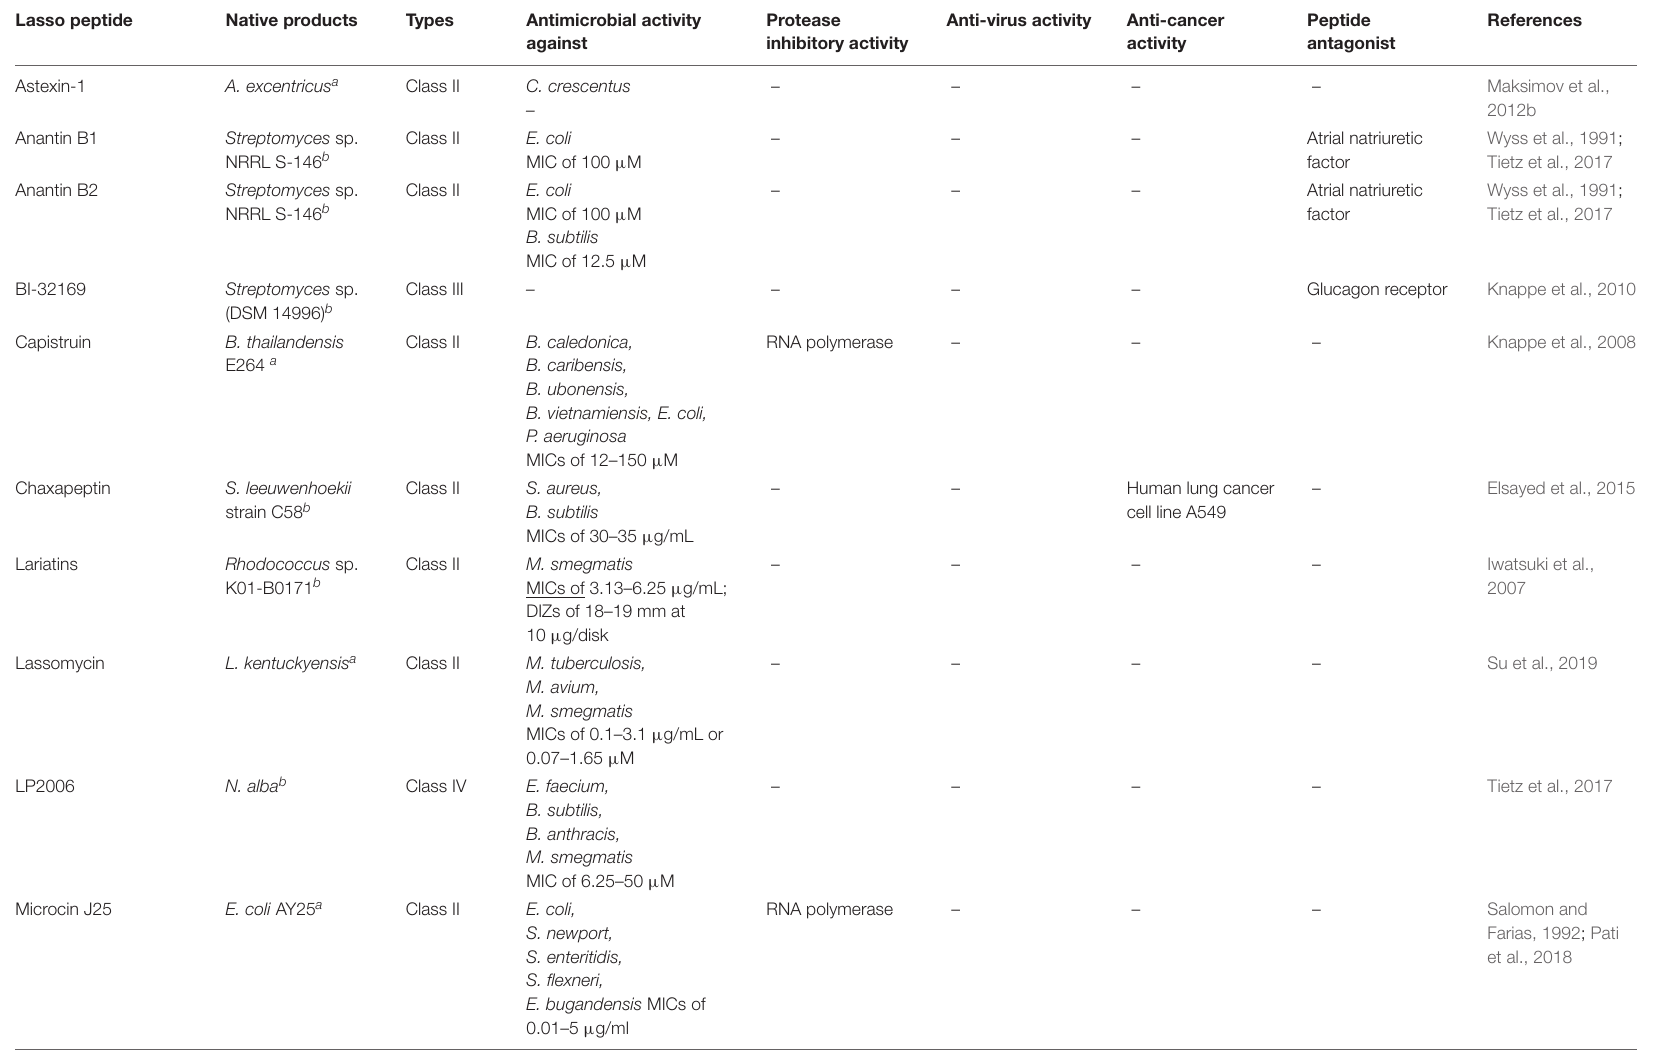
TABLE 3 | Bioactivities of known lasso